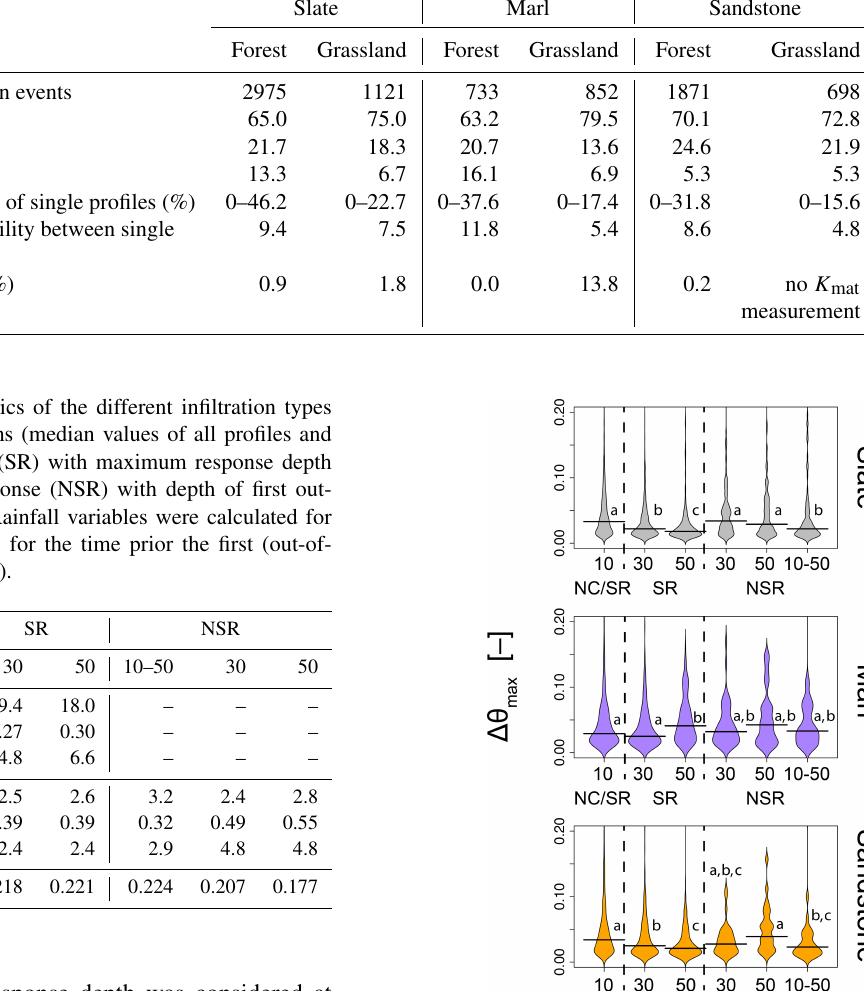
Table 3. Number of events, infiltration responses and standard deviation (SD) of the six landscape units, showing a not classifiable response (NC), sequential response (SR) and non-sequential response (NSR). Slate